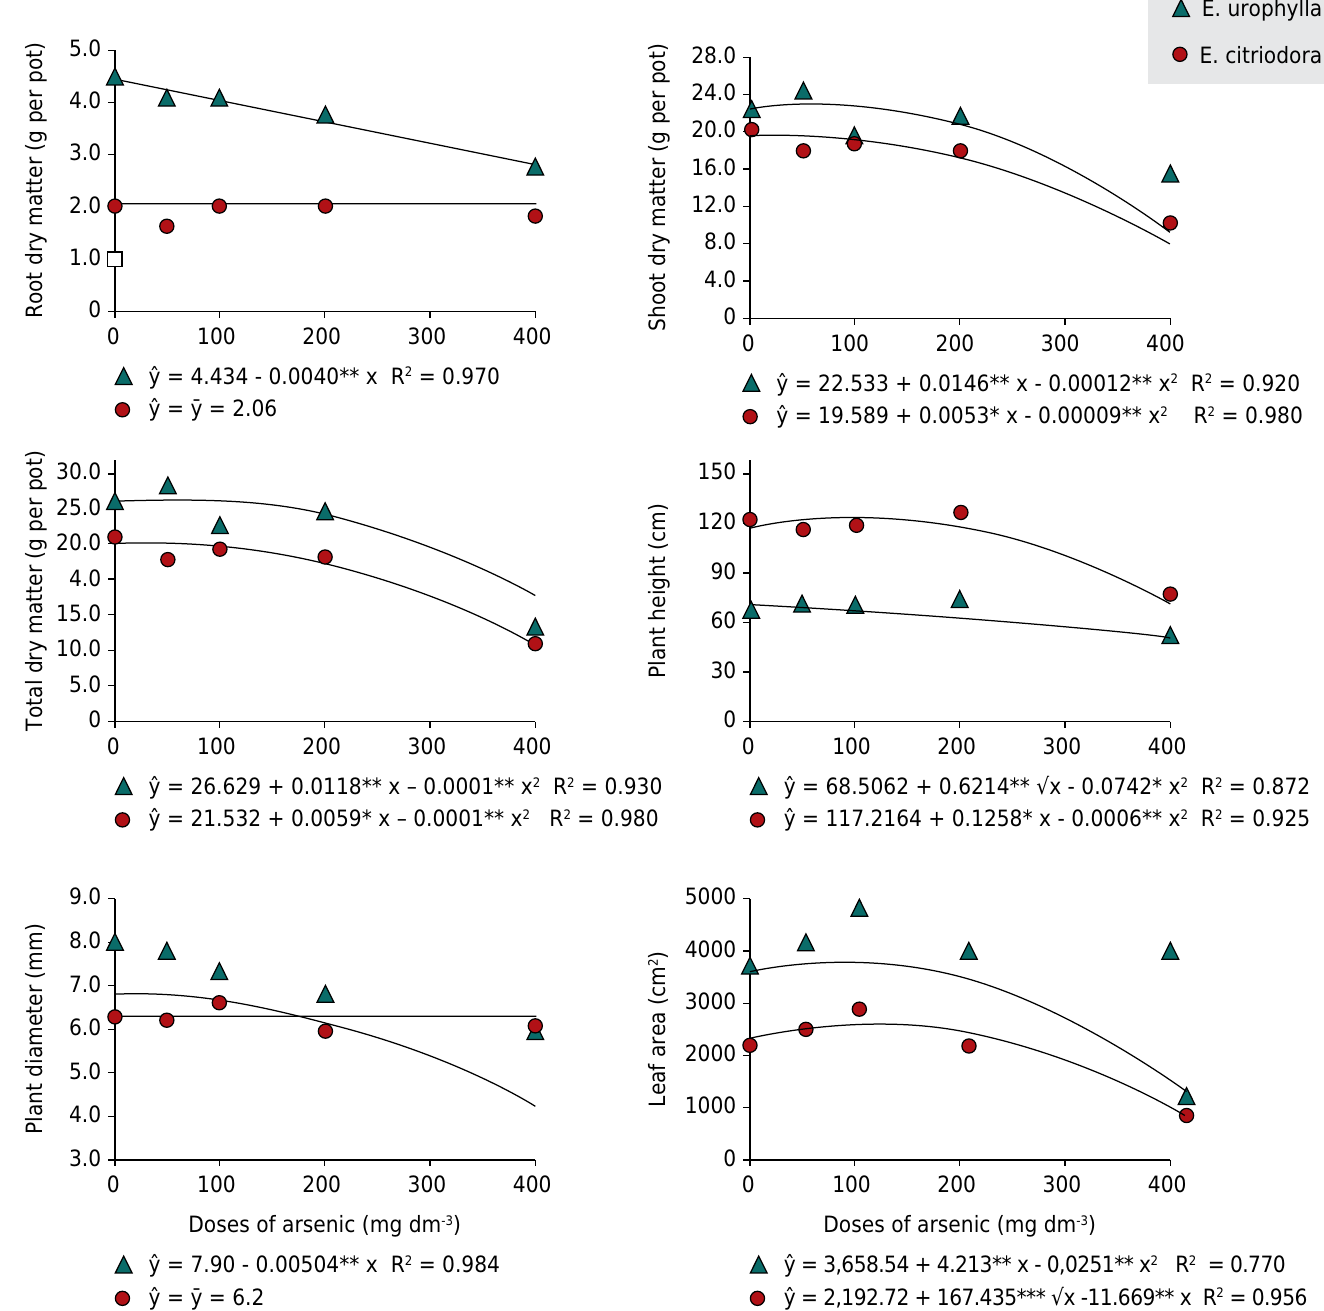
Figure 1. Root dry weight (a), shoot dry weight (b), total dry matter (c), plant height (d), plant diameter (e) and leaf area (f) of E. urophylla and E. citriodora seedlings subjected to various rates of arsenic. ***, **, *: at 0.1, 1 and 5 % significant, respectively, by the F